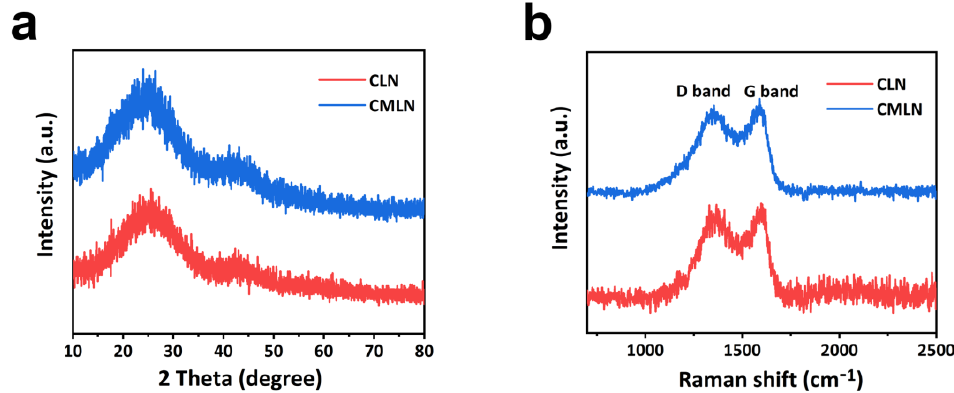
Figure 3. ( a ) XRD patterns of CLN and CMLN; ( b ) the Raman spectroscopy of CLN and